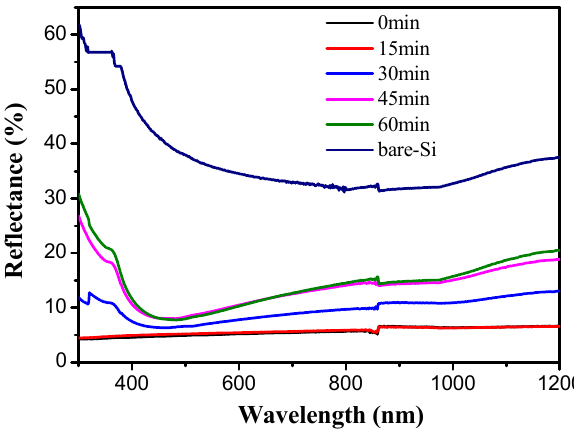
Figure 7. Reflection spectra of n-Si/PEDOT:PSS samples exposed to air for different time periods from 0 to 60 min; the reflection spectrum of the polished bare n-Si is also shown for a reference.